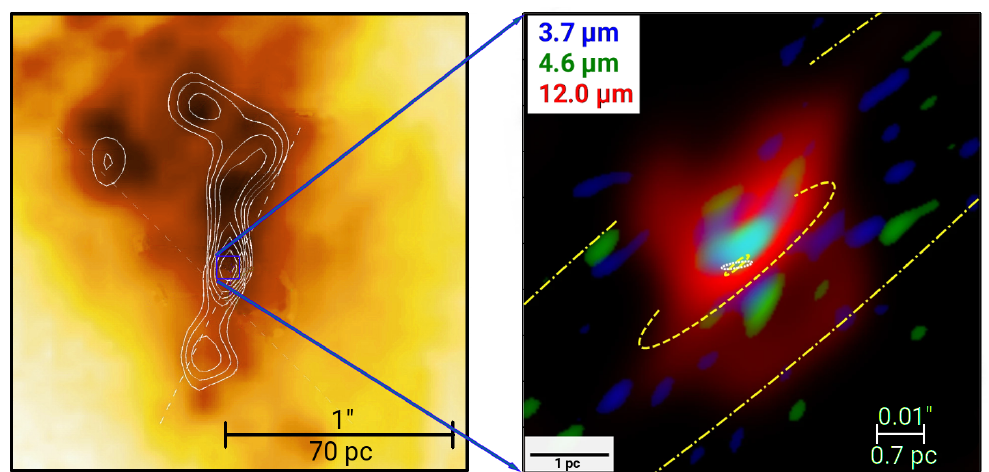
Figure 17. Optical [O III ] images overlaid with contours of the extended mid-IR dust emission (at λ = 12.5 µ m) of the archetypal Type 2 AGN in NGC 1068 ( left panel) and the near- to mid-IR reconstructed images from MATISSE interferometry observations of the same nucleus at bands L (3–4 µ m), M (4.5–5 µ m), and N (8–13 µ m) ( right panel). Modified from the original figures published in Bock et al. [59] (their Figure 4) and Gámez Rosas et al. [114] (their Figure 1e). (Left) reproduced from Bock et al. (2000) with permission; (Right) reprinted from Gámez Rosas et al.